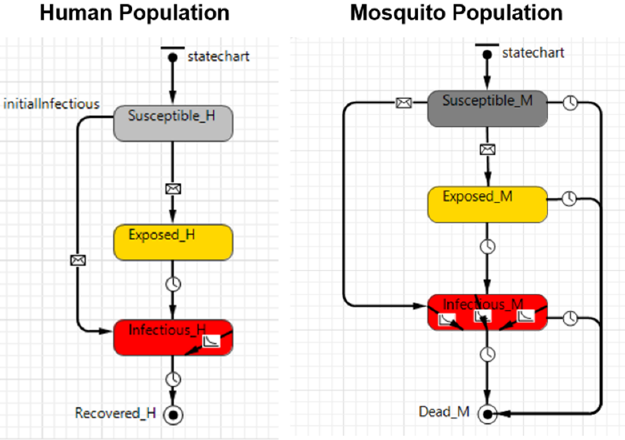
Figure 2. Snapshot of the simulation Model A (baseline).